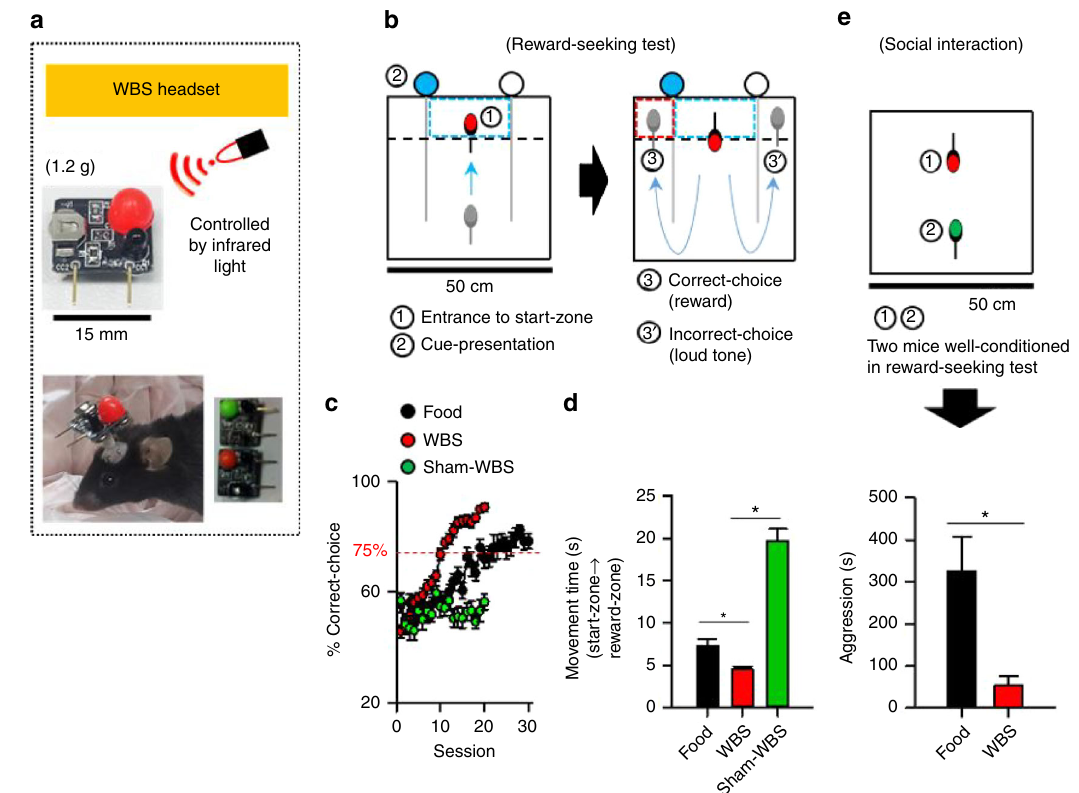
Fig. 1 Wireless brain stimulation (WBS). a A small, lightweight WBS headset was used to stimulate a reward center, the medial forebrain bundle in the mouse. b Performance with WBS was tested in a two-way choice test. c Mice were conditioned rapidly when WBS was the reward. Red-dotted line indicates the signi fi cance level of the correct choice (binomial test, P < 0.05). d Mice moved quickly from start-zone to reward-zone when WBS was the reward (One-way analysis of variance on ranks, Dunn ’ s correction, * P < 0.05). e The two mice in the WBS-reward condition displayed a shorter duration of aggression in a social interaction test than those in the food-reward condition ( t -test, * P <